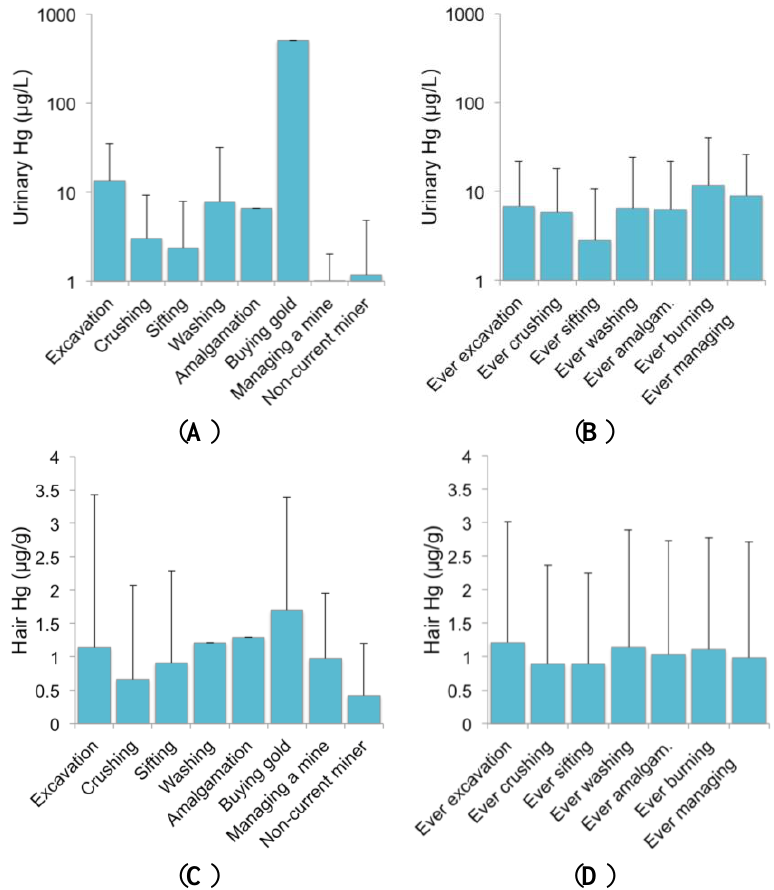
Figure 4. Median urine ( A , B ) and hair ( C , D ) Hg concentrations by Kejetia participants’ mining involvement. Bars represent mean values with the 75th percentile indicated as error bars. Median values are stratified by the main mining activity performed in the preceding three months of the interview in ( A ) and ( C ); and ever involvement in each mining activity in ( B ) and ( D